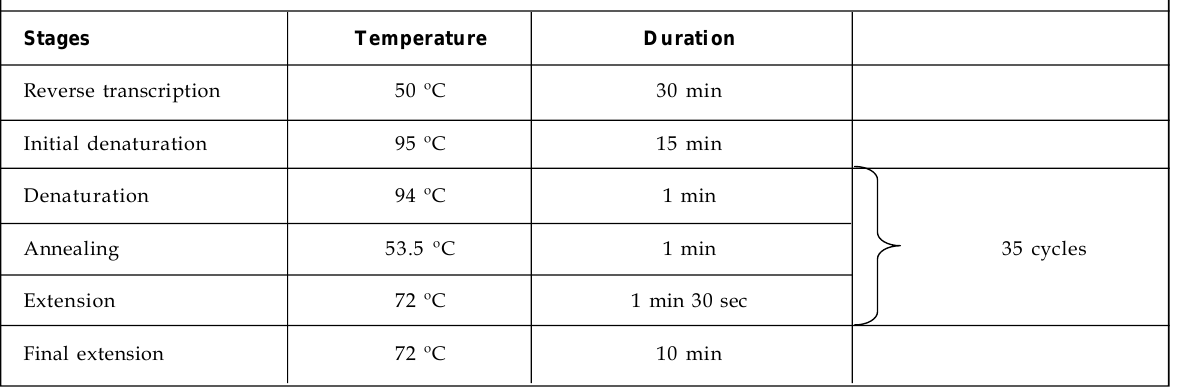
Table 1: The conditions of RT-PCR for PoMT2 gene Stages